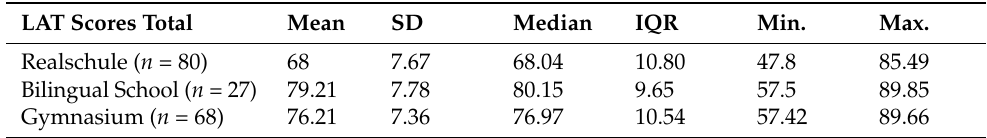
Table 5. Total LAT scores across school